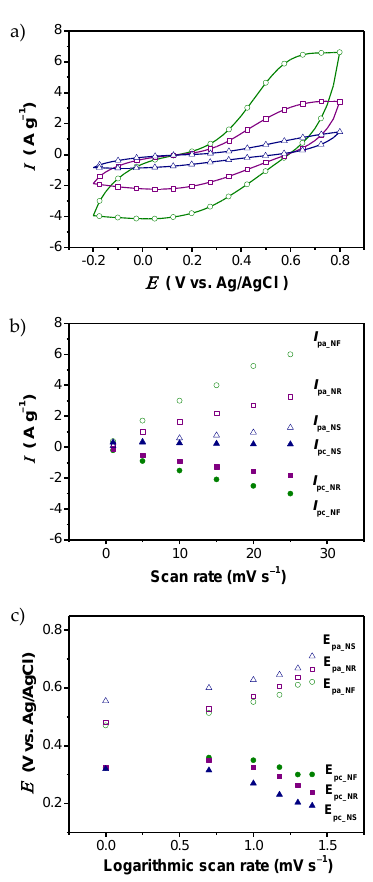
Figure 8. CV analysis of PANI nanostructures with three different shapes (nanosphere, NS; nanorods, NR; and nanofibers, NF) performed in a 1 M sulfuric acid solution. ( a ) Cyclic voltammograms of electrodes consisting of PANI nanostructures at the same scan rate (25 mV·s −1 ); ( b ) plots of the peak current (the anodic peak current, I pa ; the cathodic peak current, I pc ) vs. the scan rate; and ( c ) plots of the peak potential (the anodic peak potential, E pa ; the cathodic peak current, E pc ) vs. the log of the scan rate. With permission from [86]; Copyright 2012, American Chemical Society.